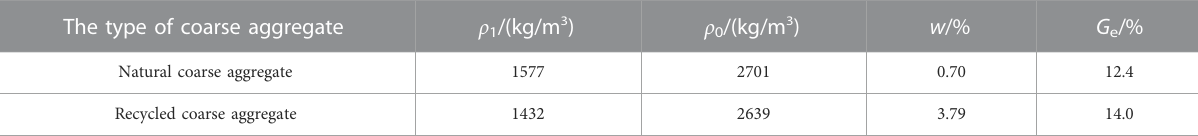
TABLE 2 Parameters of coarse